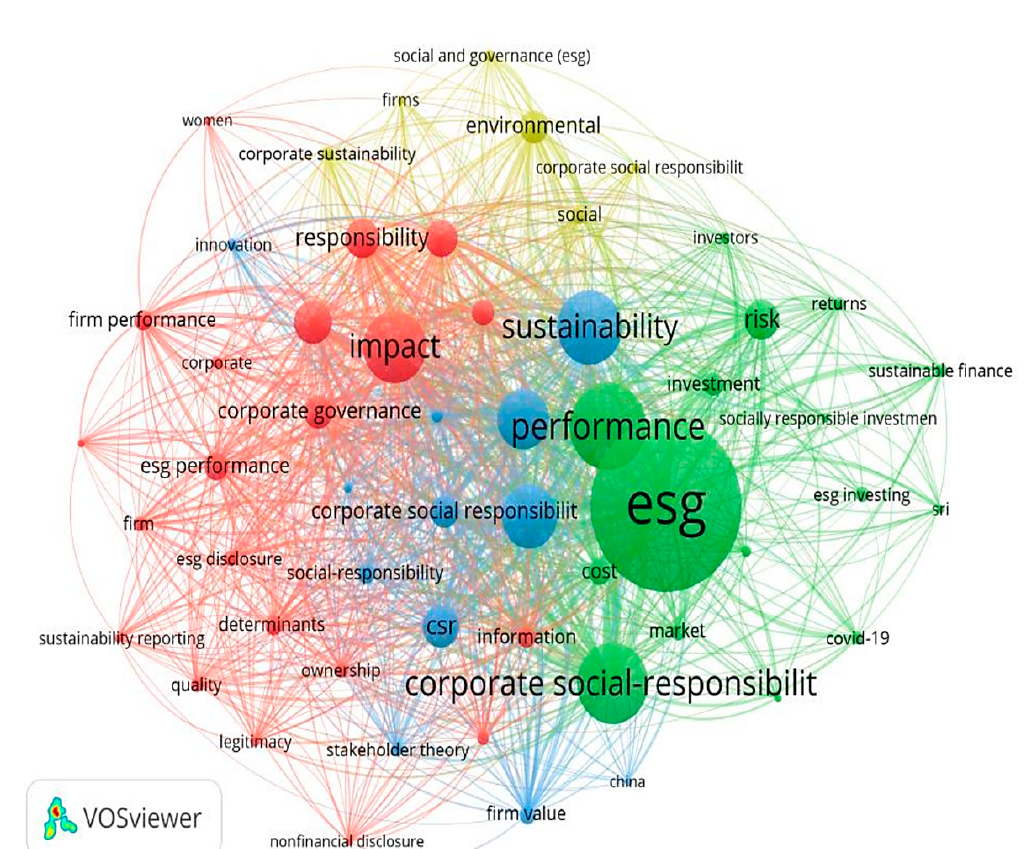
Figure 2. Links between keywords in publications from the WoS database referring to issues related to ESG risk in enterprises. Source: own elaboration with the VOSviewer application.